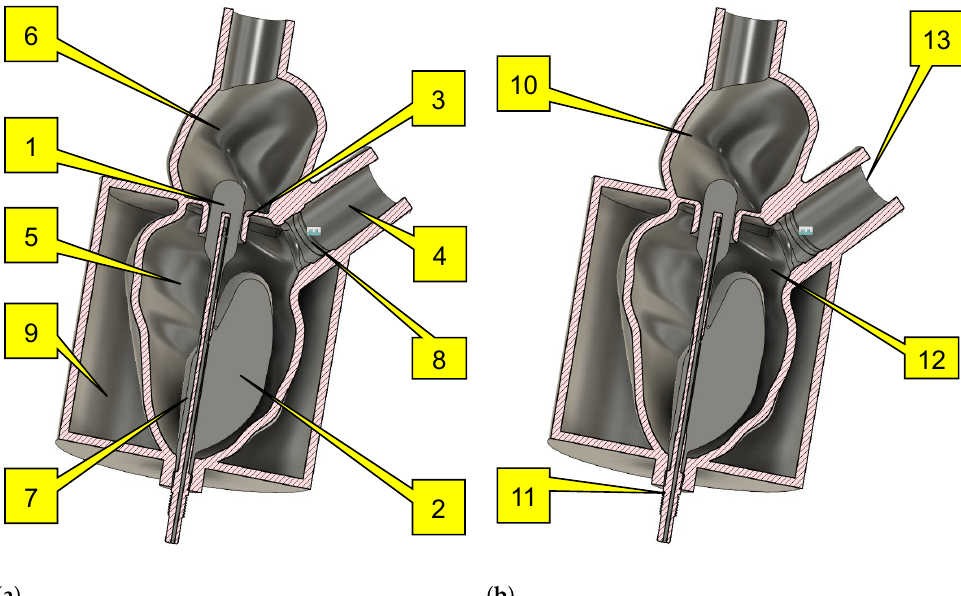
Figure 4. Flexible left heart model in a transparent cylinder—CAD model cross-section: (1)—valve balloon, (2)—ventricular balloon, (3)—mitral valve, (4)—aorta, (5)—left ventricle, (6)—left atrium, (7)— pneumatic line, (8)—mechanical aortic valve location, (9)—closed volume for air, (10)—atrial pressure sensor, (11)—balloon pressure sensor, (12)—ventricular pressure sensor, (13)—aortic pressure sensor.